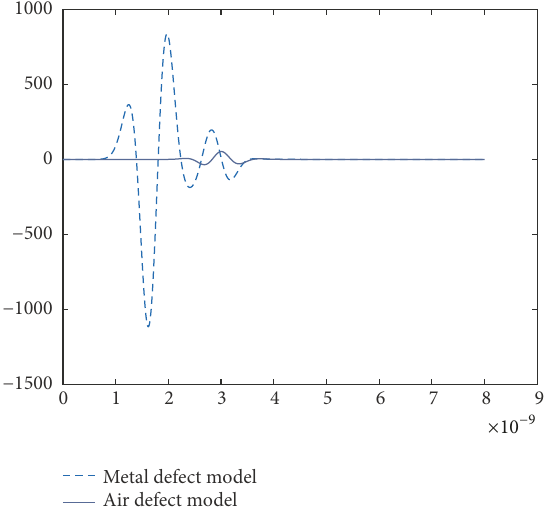
Figure 7: Comparison of scattering fields between metal defect model and air defect model.